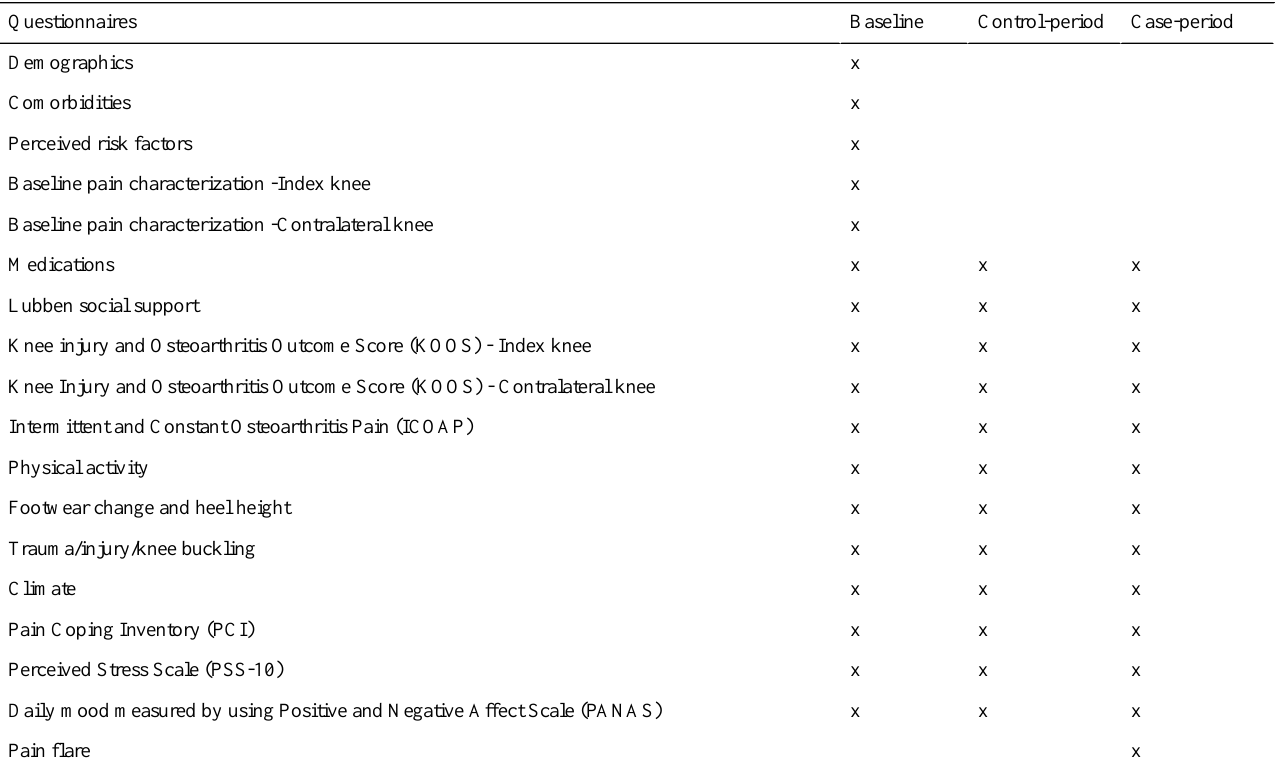
Table 1. Study website